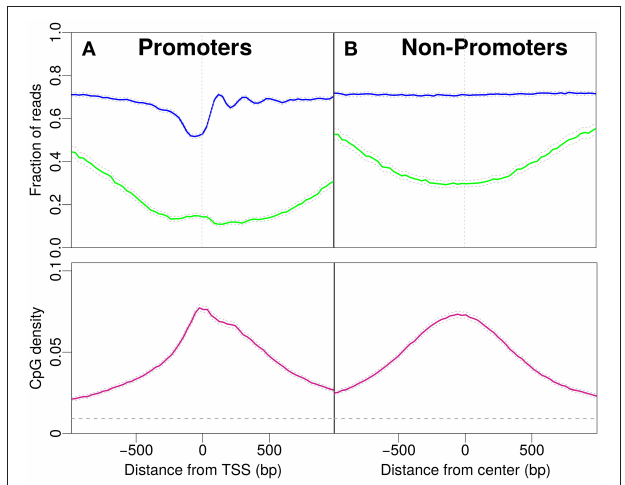
FIGURE 1 | Profiles for nucleosome occupancy (blue), methylation level (green) and CpG density (pink). For each position in the region the nucleosome occupancy, methylation level and CpG density is averaged over all promoters (see Materials and Methods). (A) Promoter regions upstream and downstream the TSS (x-axis origin). (B) Analogous to (A) for non-promoter regions. The regions are chosen to resemble the CpG density profile in (A) . The gray dashed line indicates the average CpG density (0.009) in the genome. 18,015 promoters and 17,982 regions are analyzed in (A,B) .